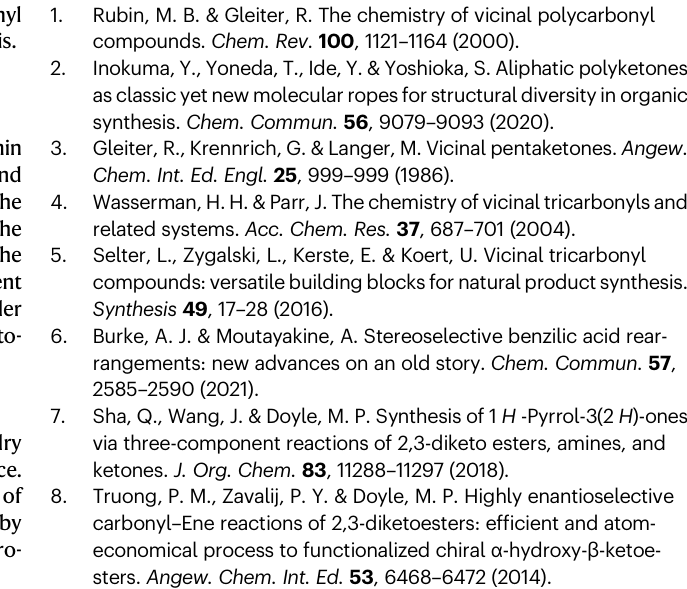
dichloroethane under an air atmosphere with 5.0 molar equivalents of water catalyzed by Rh 2 (esp) 2 yielded the 1,2,3-tricarbonyl-4-oxime and its hydrate in modest to excellent yields usually within 24 h.